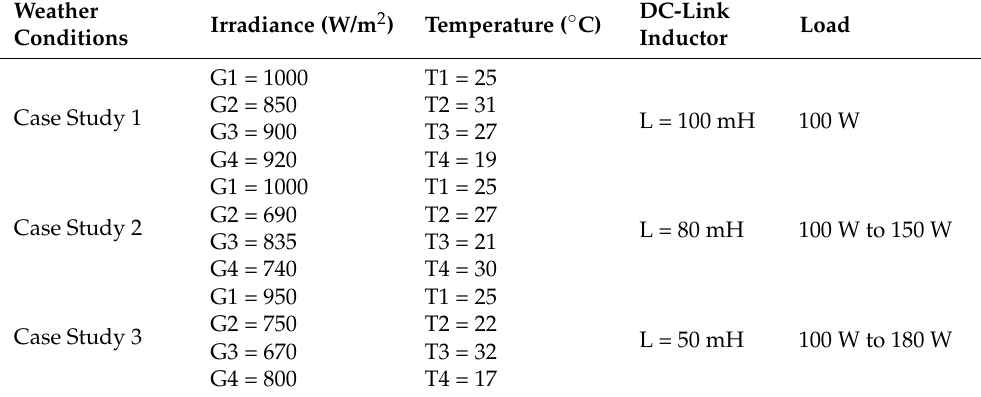
Figure 7. The MATLAB SIMULINK implementation of the proposed system. Table 3. Case studies